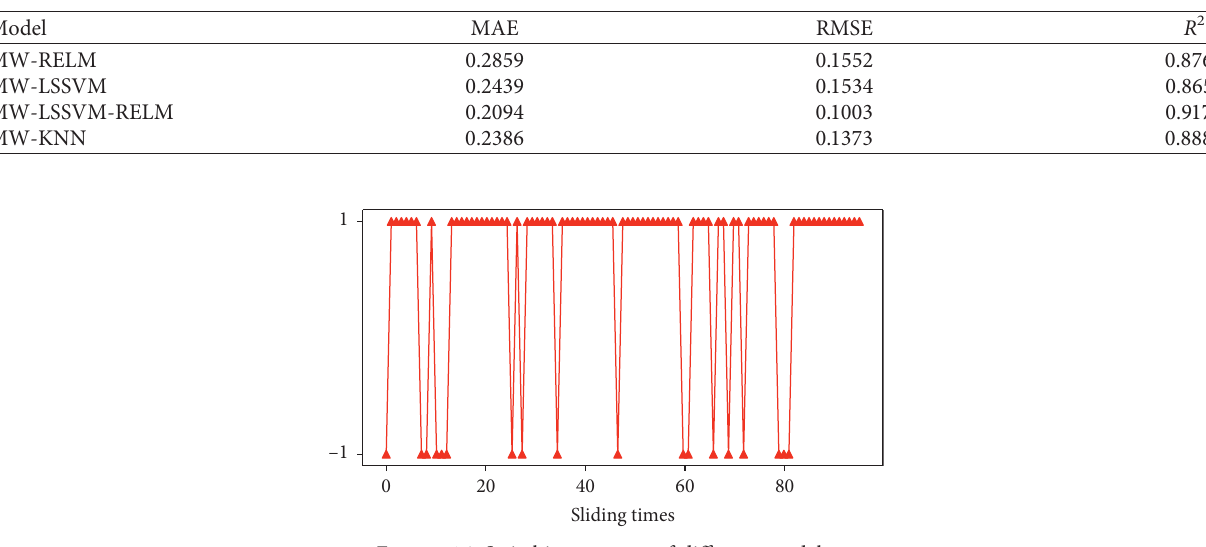
Table 11: Quantitative indicators under different models.